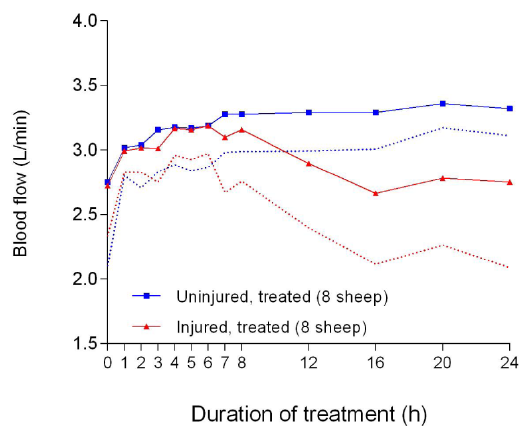
Figure 47. Blood flow (Mean ± SD) through an extracorporeal life support pump for smoke and non-smoke injured sheep that received treatment. Dotted lines represent one-sided error bars.